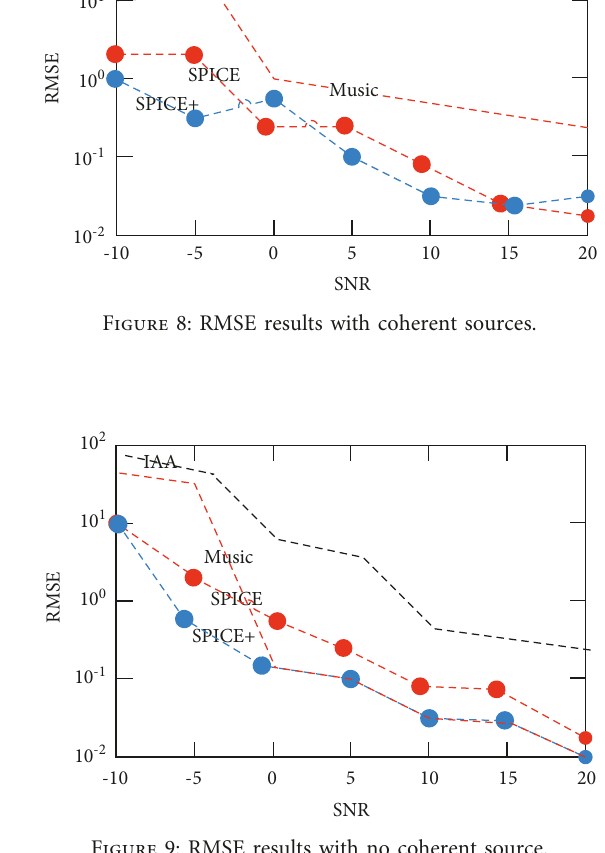
Figure 9: RMSE results with no coherent